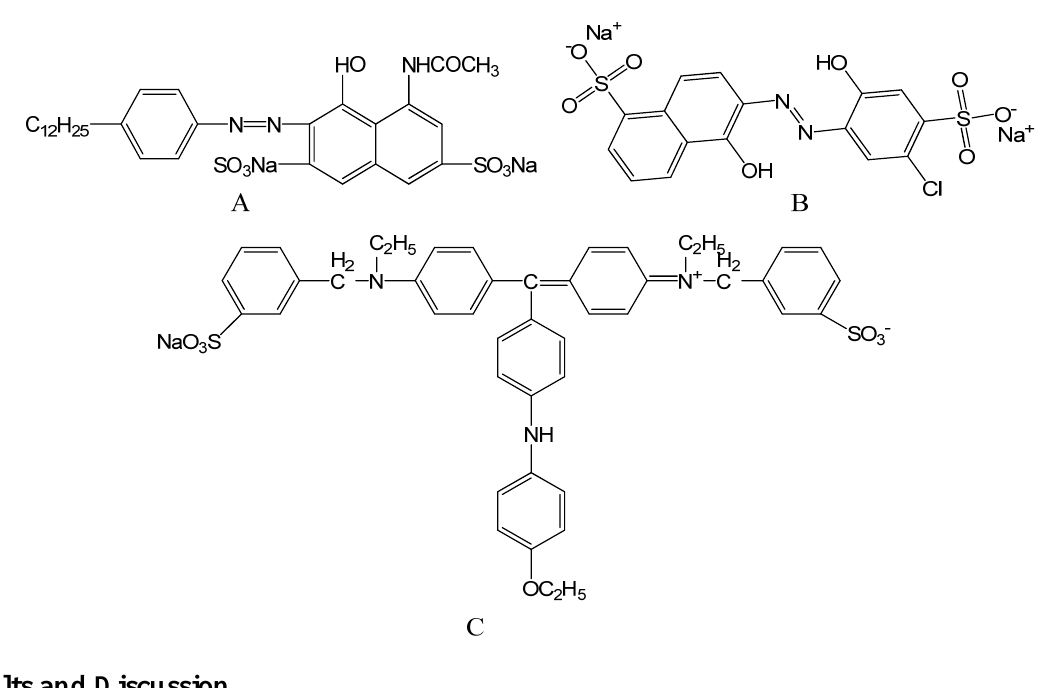
Figure 1. Molecular structures for APRB ( A ), MB ( B ) and ABB6B ( C